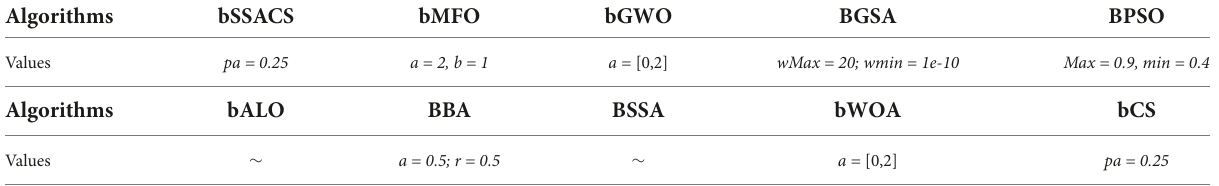
TABLE 7 Parameter setting of the optimization algorithms.